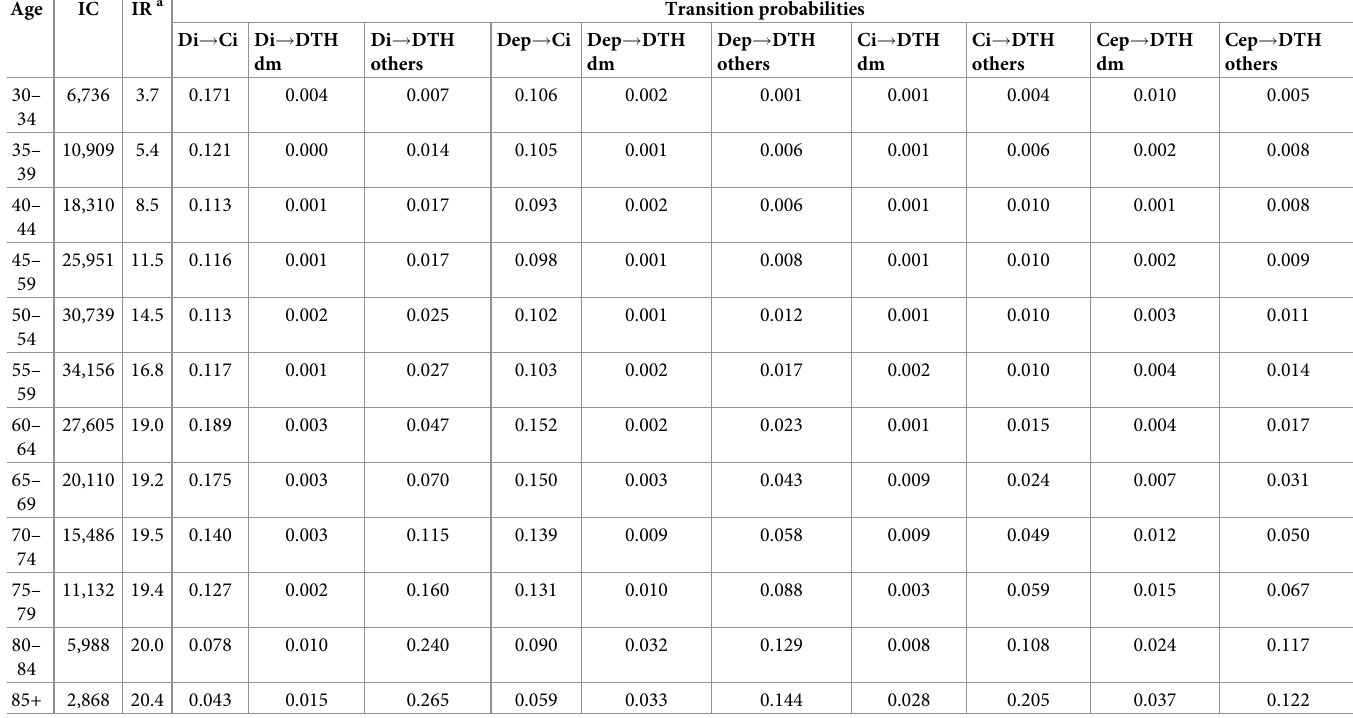
Table 1. Transition probabilities of males by age